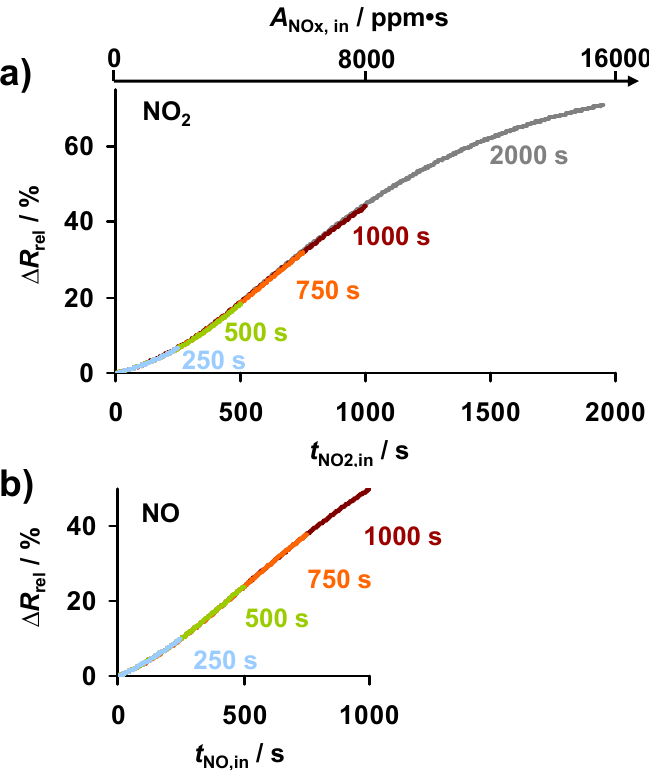
intervals with intermediate regeneration: x during NO for NO exposure of t as indicated, ( b ) ∆ R rel 2 2 NO2,in as NO,in